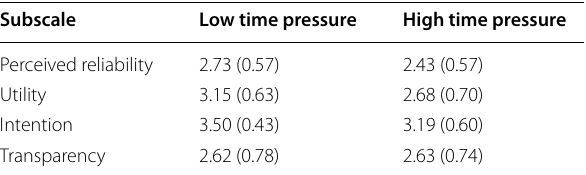
Table 2 Questionnaire data: FMV (means and